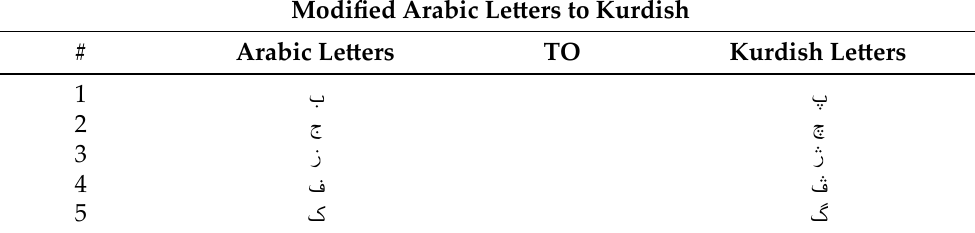
Table 4. Modified Arabic letters to Kurdish